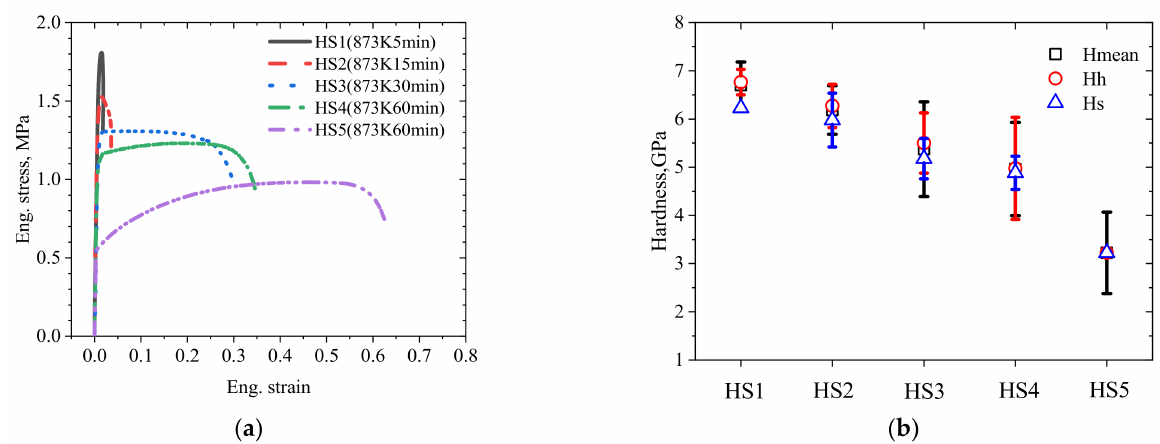
Figure 3. Mechanical properties of the CrCoNi MEAs subjected to different heat treatments. ( a ) Tensile stress–strain curves. ( b ) Statistical data of the indentation hardness at the TD directions of the specimens.